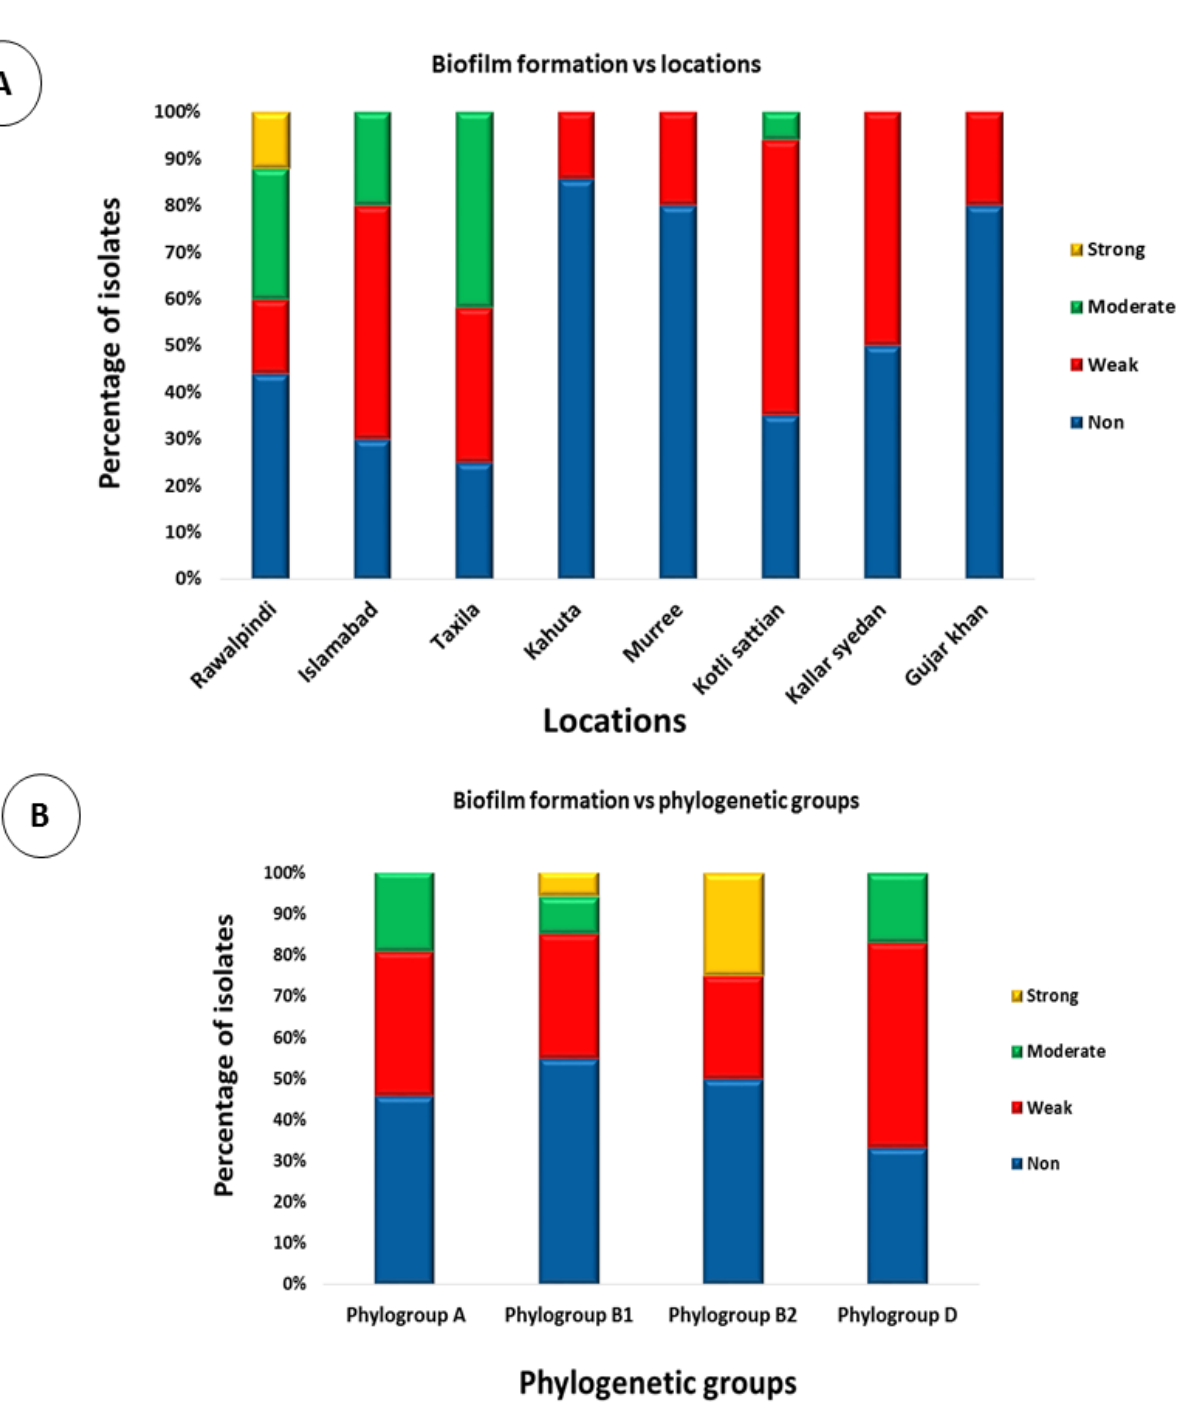
Figure 8. Phenotypic associations: ( A ) stacked bar chart showing the comparison of biofilm formation by E. coli strains isolated from various locations, and ( B ) stacked bar chart showing the comparison of biofilm formation by E. coli strains from different phylogenetic groups.